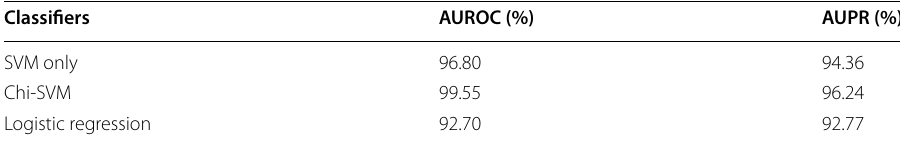
Table 5 Results of Spark-Chi-SVM model